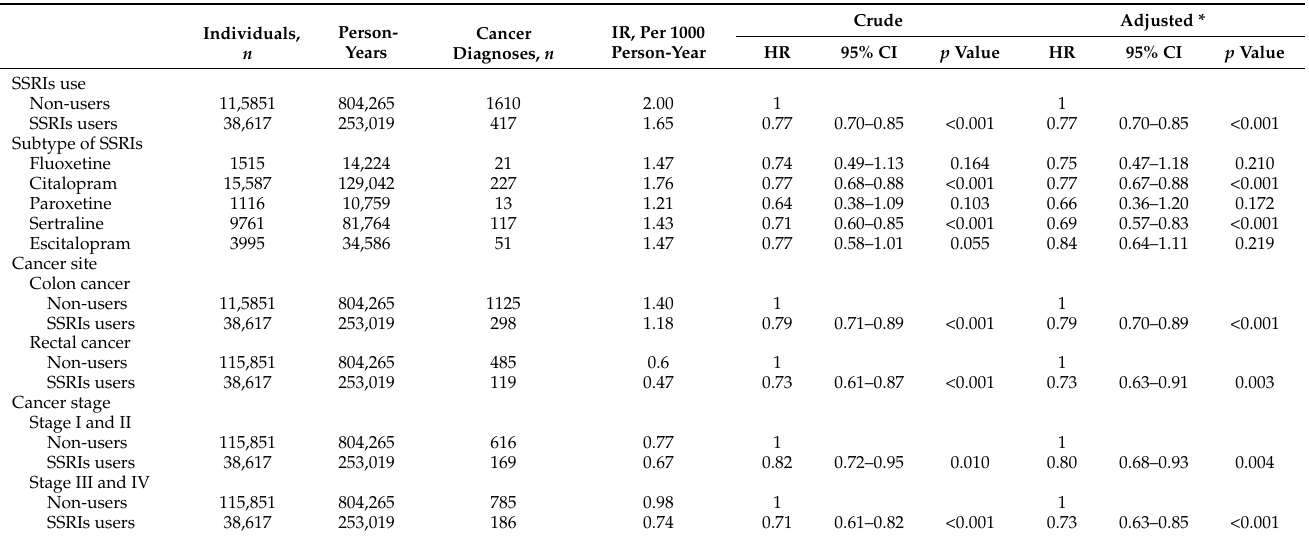
Table 2. Hazard ratios and 95% confidence intervals of colorectal cancer associated with SSRI use among individuals with a family history of CRC.